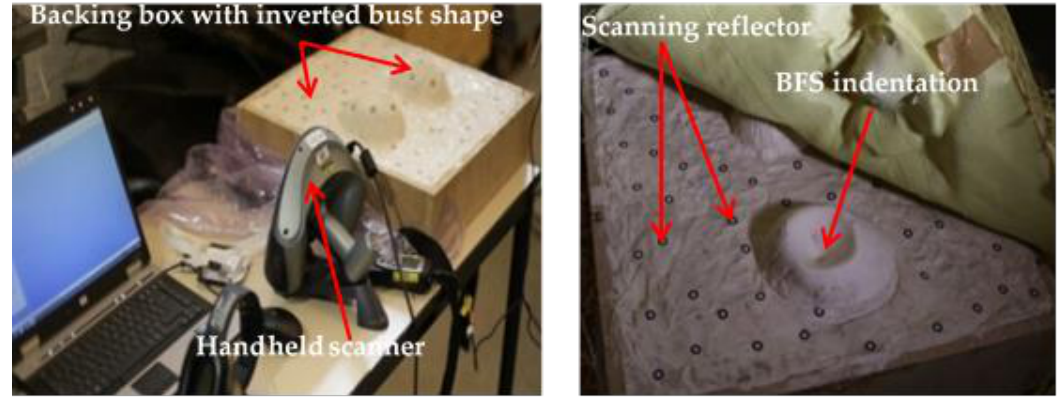
Figure 6. Scanning of Blunt trauma indentations on the backing material after the test using the handheld scanner.